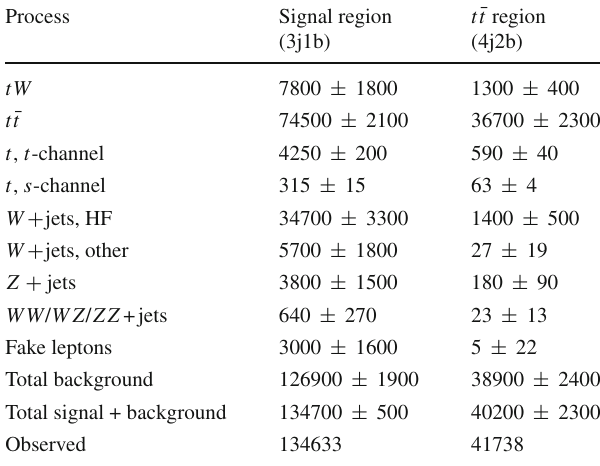
Table 3 Post-fit signal and background and observed number of events in the signal region and the t ¯ t validation region. The uncertainties include statistical plus all systematic uncertainties (cf. Sect.